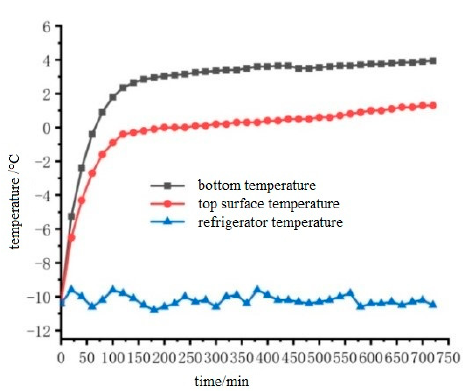
Figure 21. Temperature rise diagram of pouring conductive asphalt concrete slab without barrier.